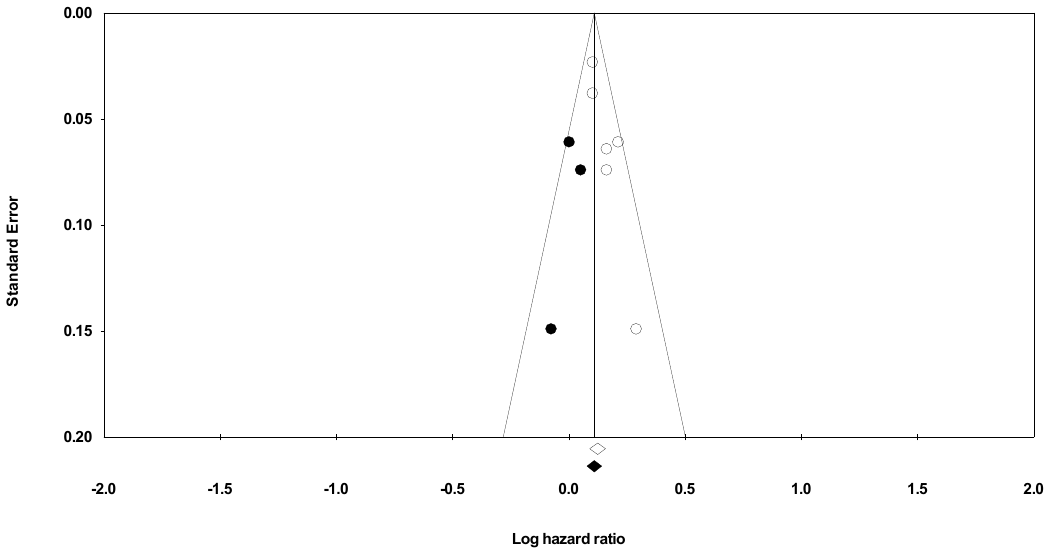
Figure 3. After using the trim and fill method of Duvall and Tweedie, a funnel plot of the observed and plotted studies for assessing the association between HAP and CVD-related mortality. The white circles represent the observed studies, and the black circles represent the plotted